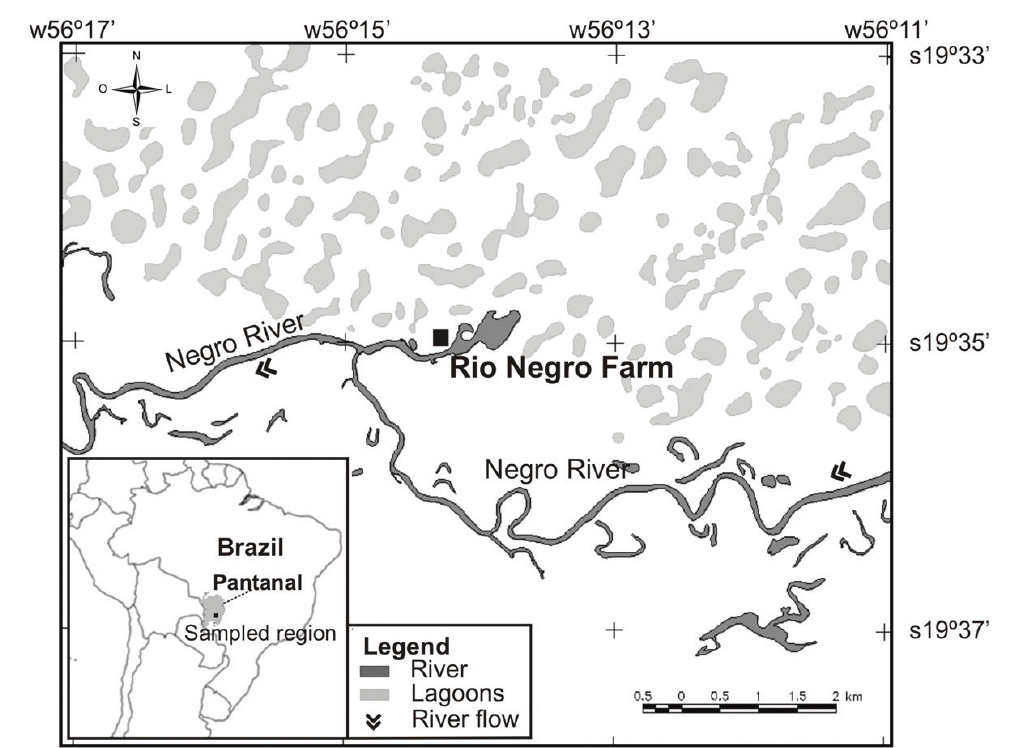
Figure 1. Location of the study area in the middle stretch of the Negro River, Nhecolândia region, Pantanal,